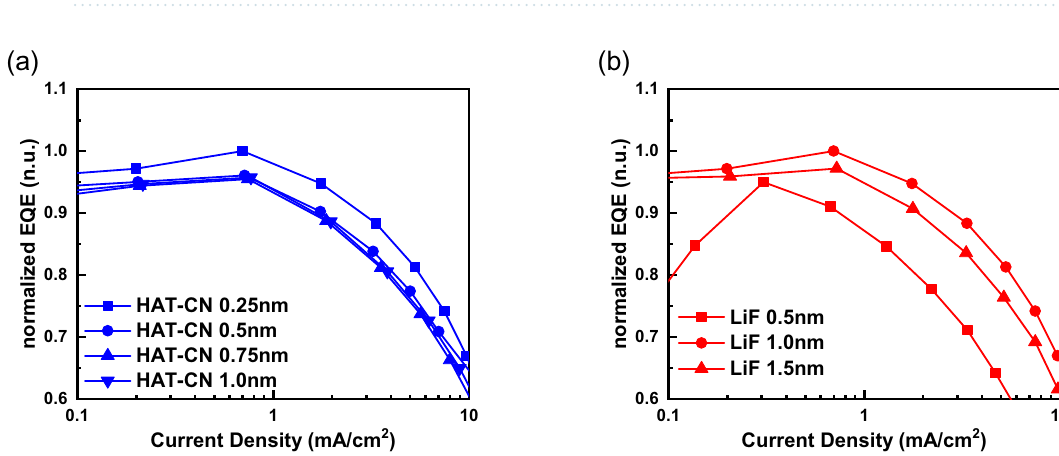
Figure 4. Normalized EQE characteristics as a function of current density: ( a ) HIL (HAT-CN) thickness changed, ( b ) EIL (LiF) thickness